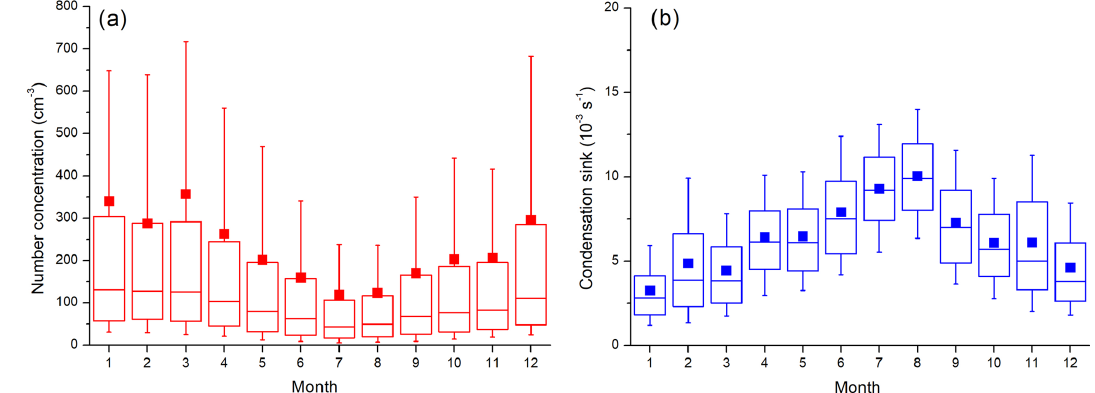
Figure 1. Monthly average variation in (a) nucleation mode particle number concentration and (b) sulfuric acid condensational sink (CS) at Finokalia station over the period June 2008–June 2018. Whiskers represent 10th and 90th percentiles, box edges are 75th and 25th percentiles, the line in the box is the median, and the solid square is the mean.